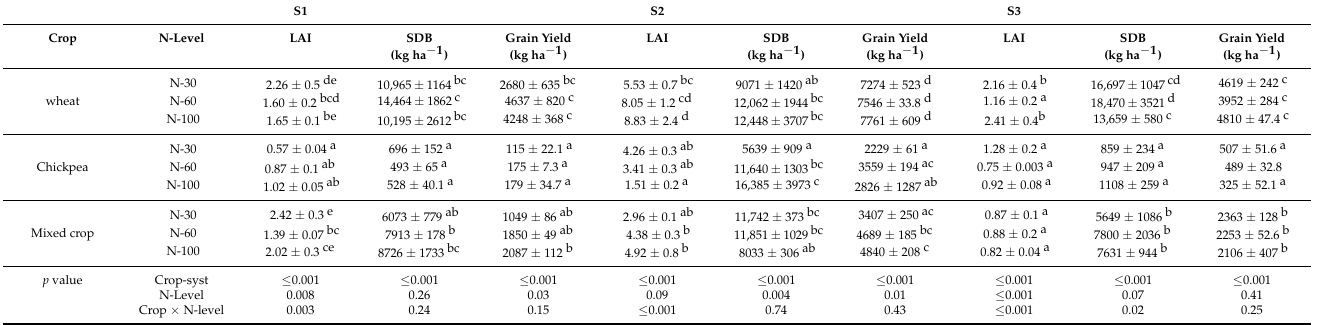
Table 3. Leaf area index (LAI), shoot dry biomass (SDB) and grain yield in chickpea, durum wheat and crop mixture under different crop-N level treatments in the different studied